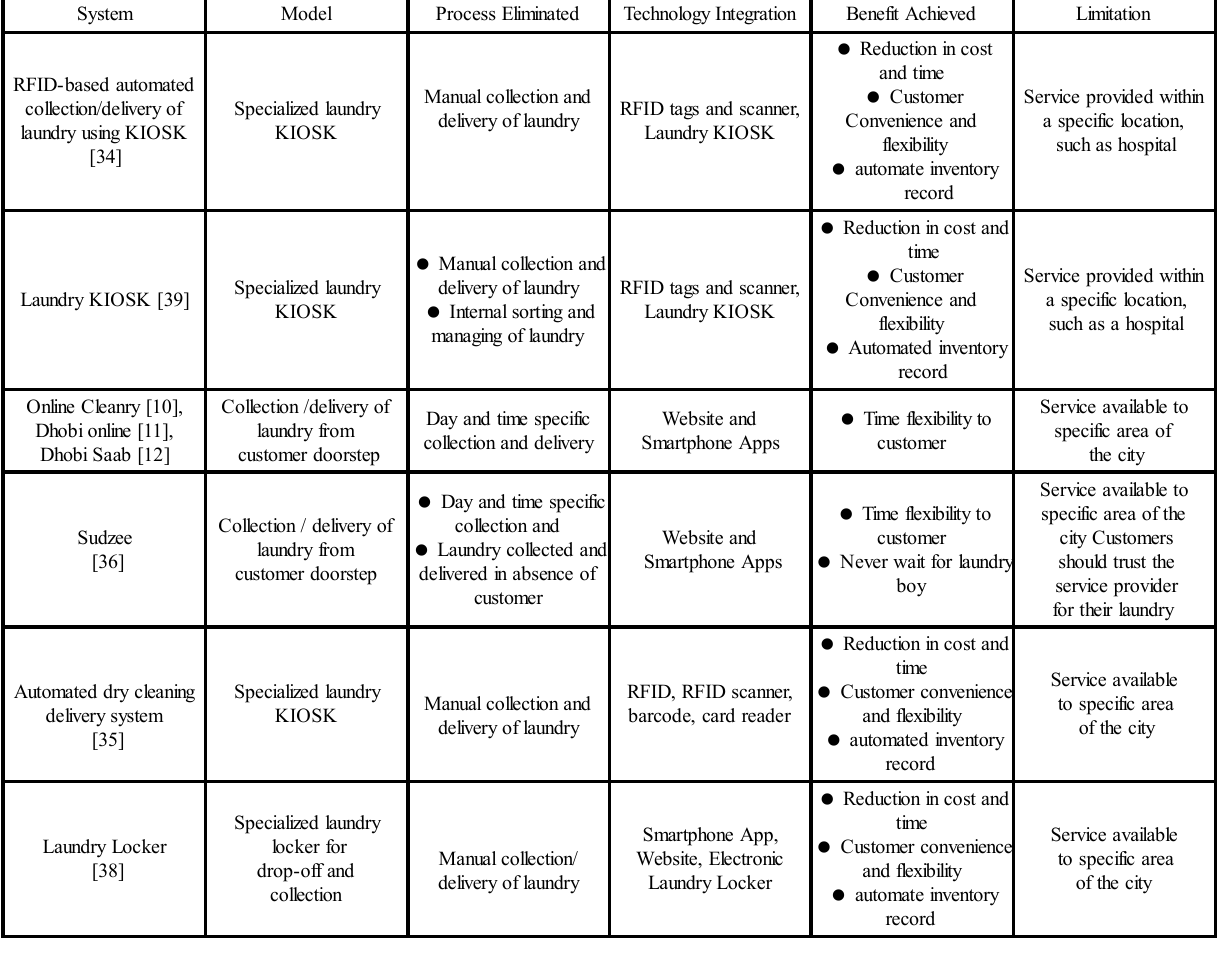
TABLE 1. COMPARISON TABLE OF COLLECT/DELIVERY LAUNDRY